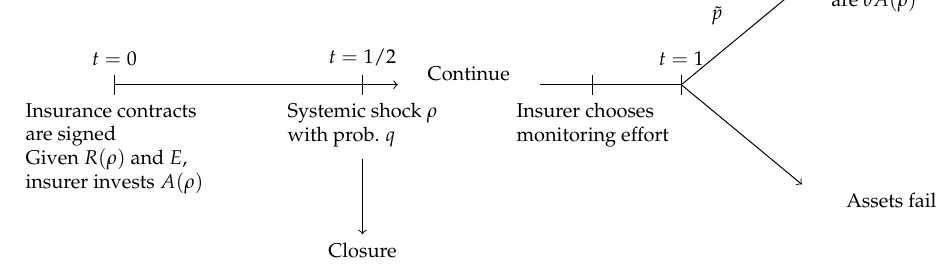
Figure 2. Timeline with systemic